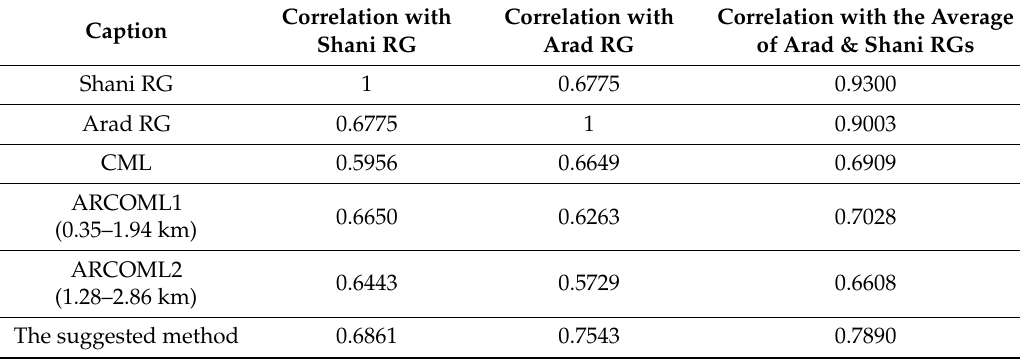
Figure 5. March 2016 event, estimated Cl B levels (blue circles and dashes) and the ground truth of observed Cl B at nearby weather station (black). Table 2. The correlation of the ground truth rain rate measurements of rain gauges (RGs) in Arad, Shani and their average, with the different measurement sources for rain rate (RGs, commercial microwave link (CML), averaged radar cells over microwave link (ARCOML) at two different elevations, and the suggested method of estimating rain rates near ground by combining radar and microwave link measurements) over the duration of 20 h on 26–27 May 2016 at the experiment site between the cities of Arad and Shani in southern Israel. Values marked in green show best values, values marked at yellow show second best values, and third best marked in purple for a specific column.